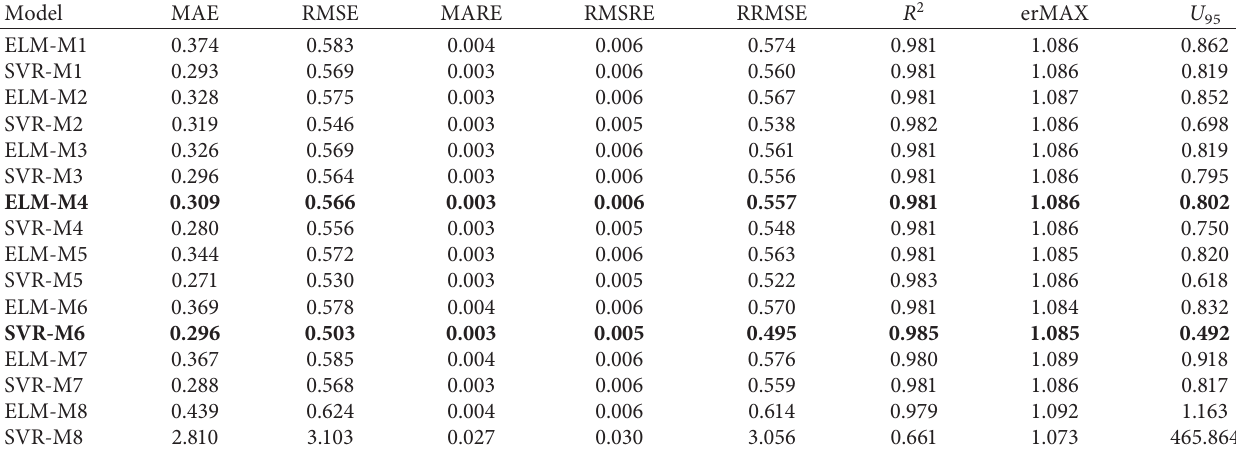
Table 4: Statistical criteria of each predicted models for USGS 14150000 station during the training